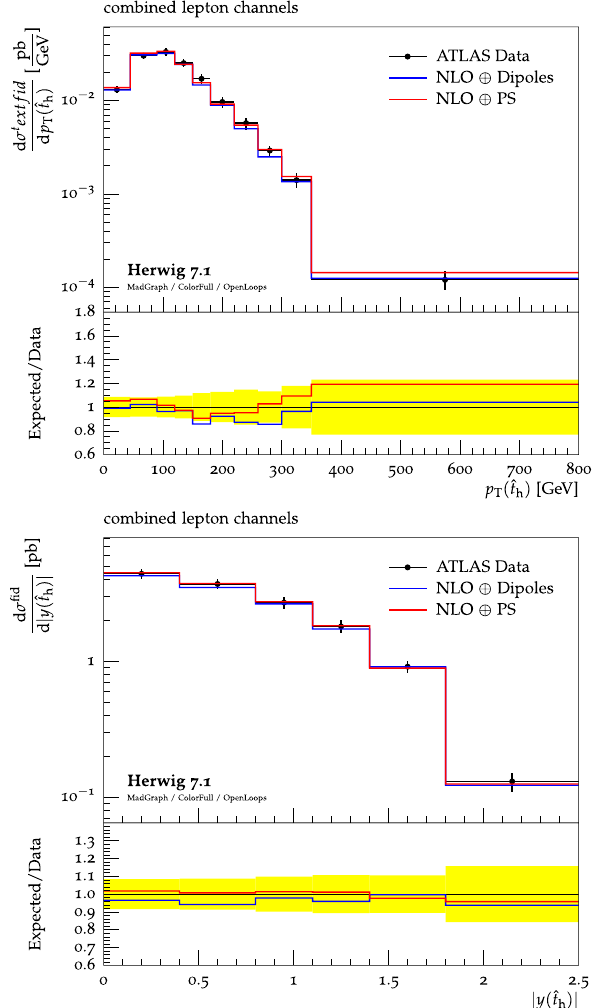
Fig. 4 Properties of top pair production in 7 TeV collisions at the LHC, as measured by ATLAS [24] and predicted by the QTilde and Dipole showers using the NLO+PS setup of Matchbox in Her- wig 7.1. More details will be presented in a forthcoming publica- tion [25]. For these results we have used our run-time interfaces to MadGraph5_aMCatNLO [14] and OpenLoops [15] to evaluate scat- tering amplitudes for each phase space point, and ColorFull [16] to perform the colour algebra